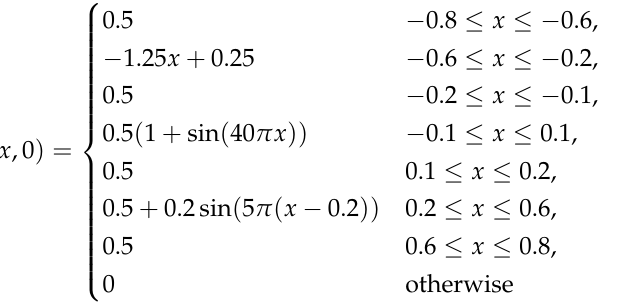
Figure 9. Numerical results by the schemes with N ∈ odd and BM = 1 at t = 2, J = 4.